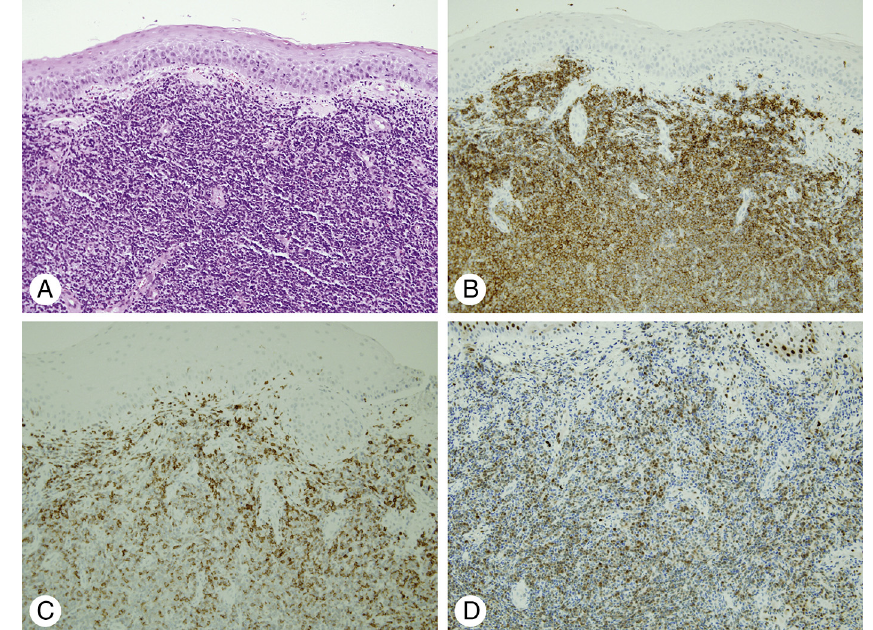
Figure 3 Histopathologic findings of nasopharyngeal mass. (A) Microscopic finding shows diffuse infiltration of small lymphocytic cells with mild nuclear atypia (H&E, × 200). Immunohistochemical staining shows strong positivity to anti-CD20 (B), anti-CD5 (C), and anti-cyclin D1 (D) antibody ( ×